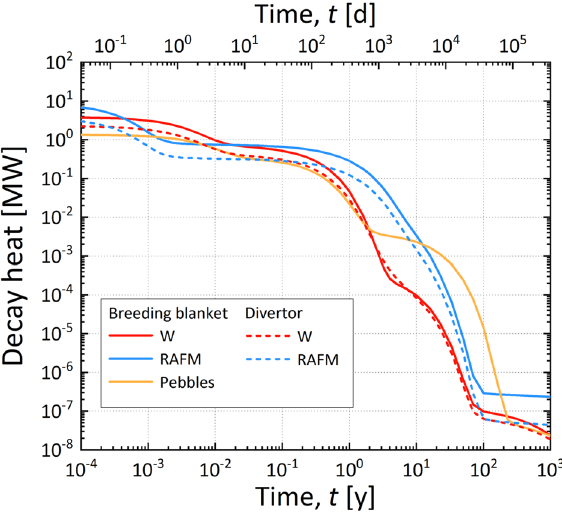
Figure 6. Transient decay heat from the in-vessel components of breeding blankets and divertors in K-DEMO after plasma shutdown. The pebbles (yellow line) are the functional material composing the breeder and neutron multiplier.